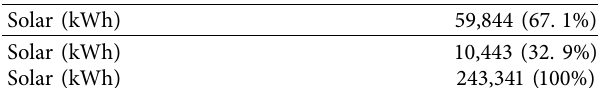
Table 10: The amount of energy fraction extracted in different ways (Scenario 4).